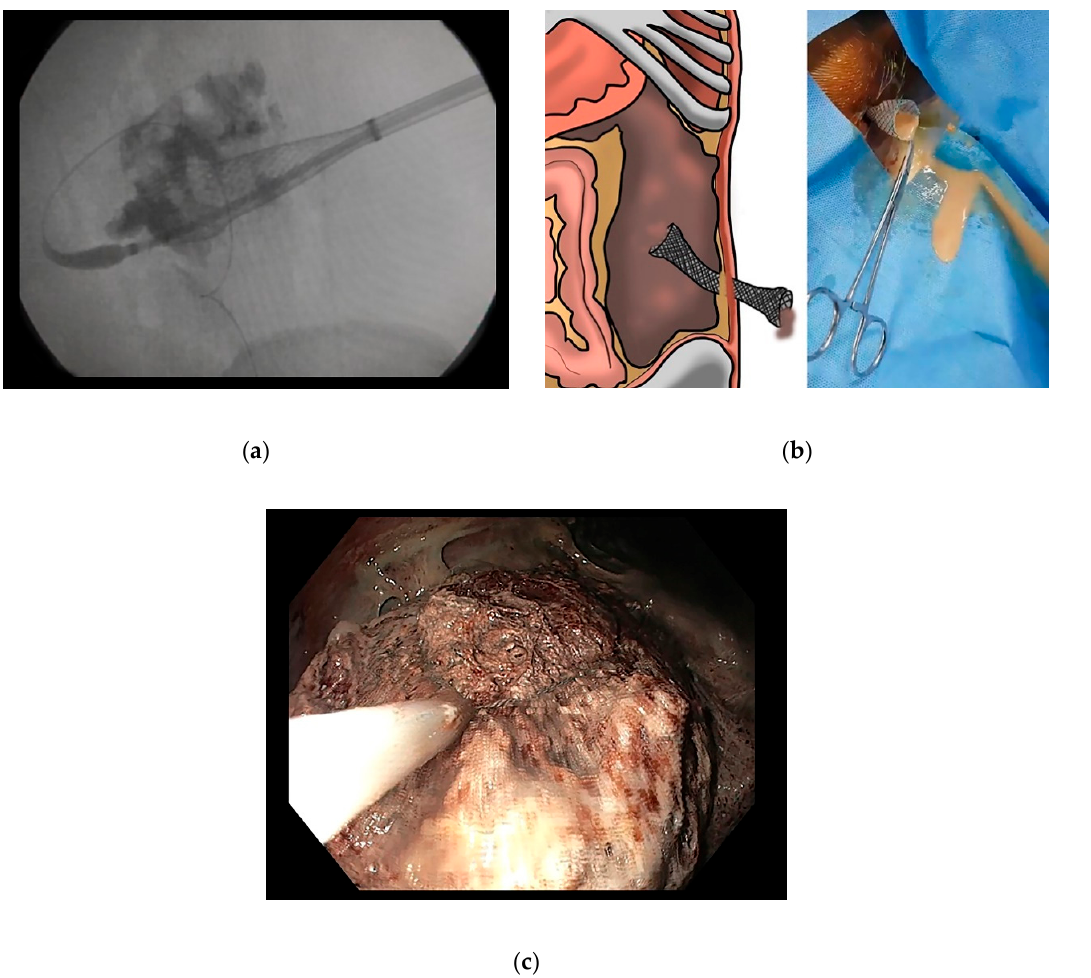
Figure 3. Percutaneous necrosectomy. ( a , b ) After percutaneous catheter insertion, a fully covered esophageal stent is placed in the cavity under fluoroscopic guidance. ( c ) Endoscopic necrosectomy can be performed using a small caliber endoscope.